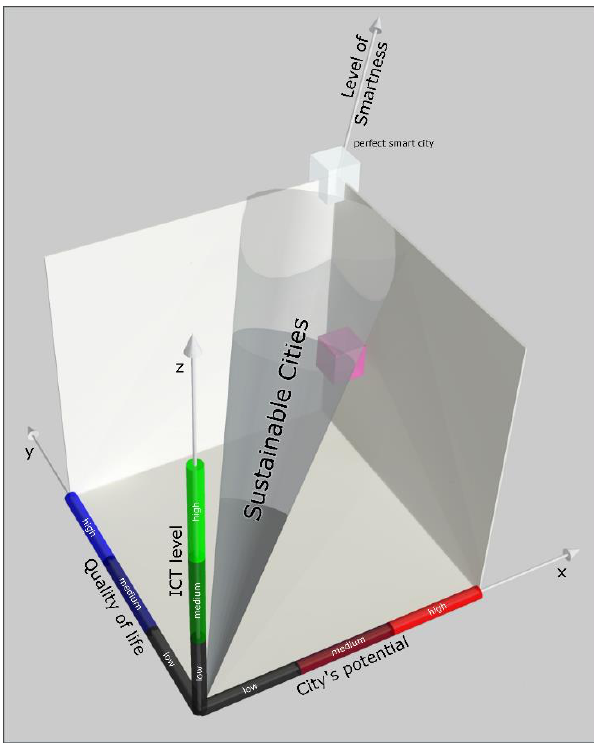
Figure 6. Summary evaluation of Warsaw in the proposed 3D model.